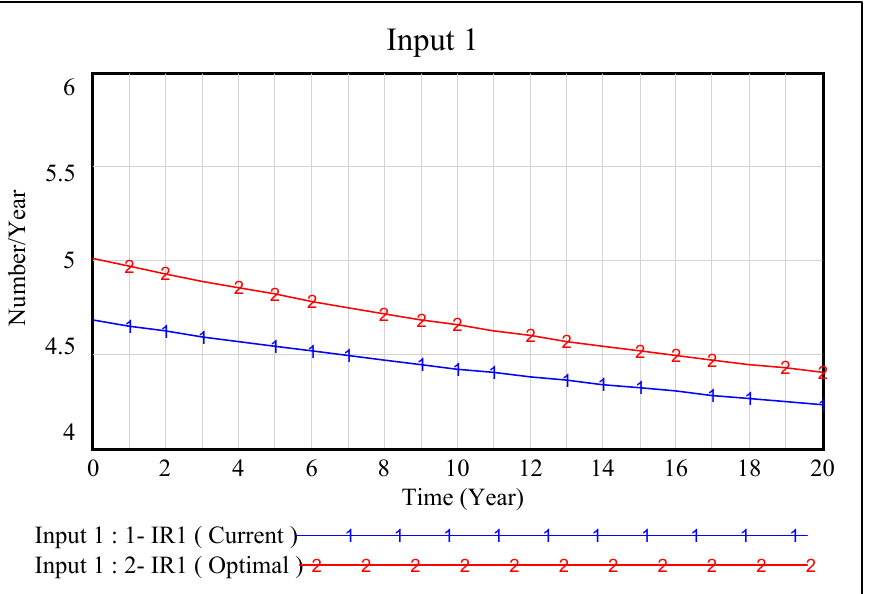
Figure 12. Comparison of the effect of the current and optimal input rate 1 on the input current variable 1.